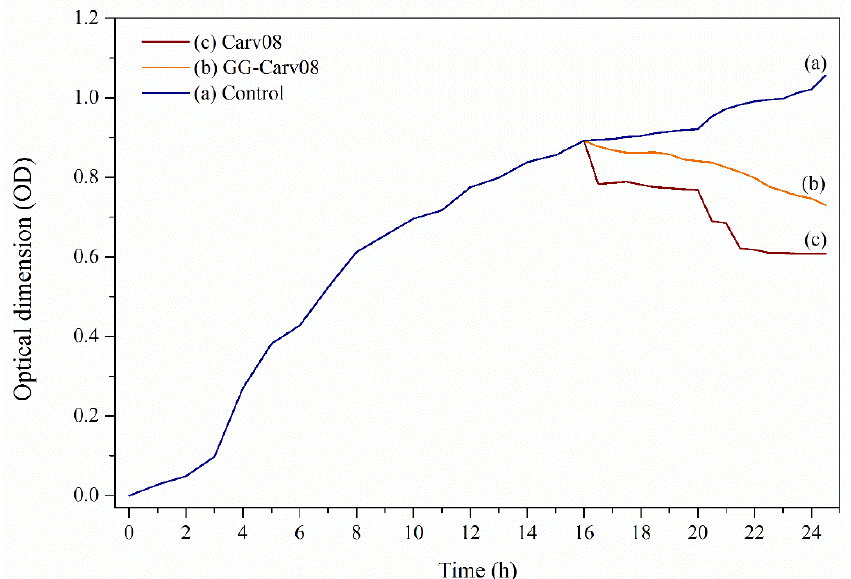
Figure 7. ( a ) The growth profile of E. coli culture without further addition and further addition of ( b ) GG-Carv 08 and ( c ) Carv 0.08 M, after 16 h incubation of E. coli ( b ) GG-Carv 08 and ( c ) Carv 0.08 M, after 16 h incubation of E. coli culture.